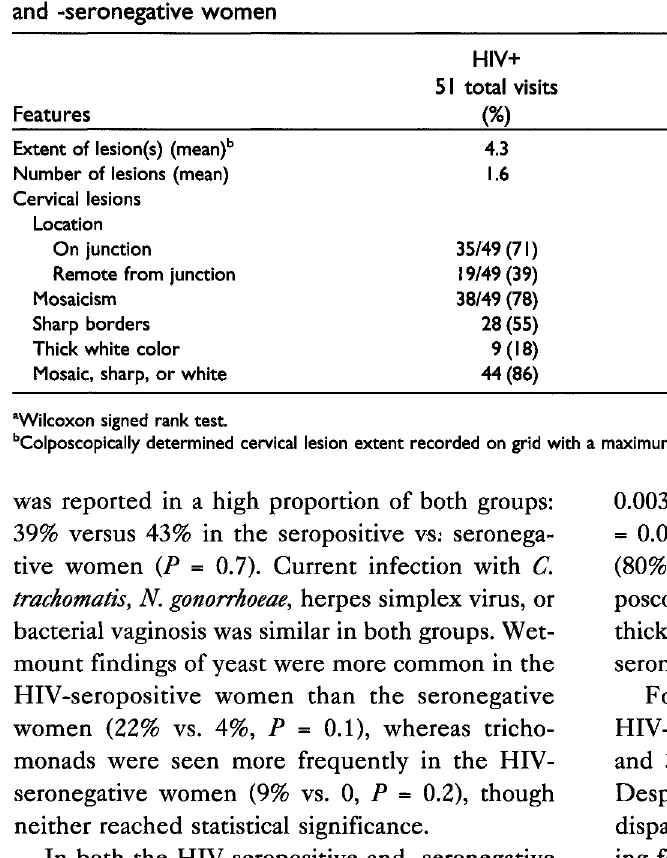
TABLE 2. Colposcopic features of cervical lesions seen initially and in follow up in matched HIV-seropositive and -seronegative women